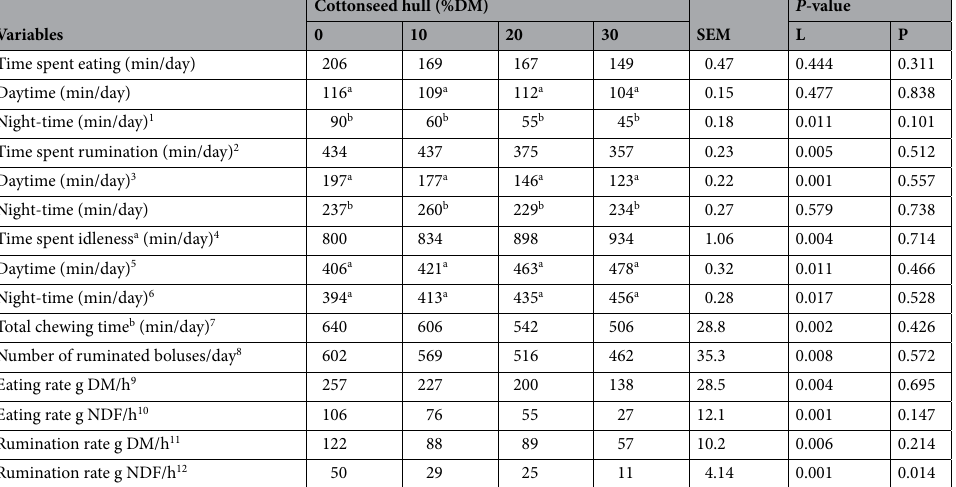
Table 3. Ingestive behaviour data of rams fed different levels of cottonseed hull. a Idling time includes all other activities that are not eating or rumination. b Total chewing time includes eating and rumination activities. Means followed by the same letter within the same column and variable are not significantly different (P > 0.05) by t-test. 1 Y = 1.381 − 0.023X; 2 Y = 4.493 − 0.034X; 3 Y = 3.278 − 0.042X; 4 Y = 9.052 + 0.157X; 5 Y = 6.622 +